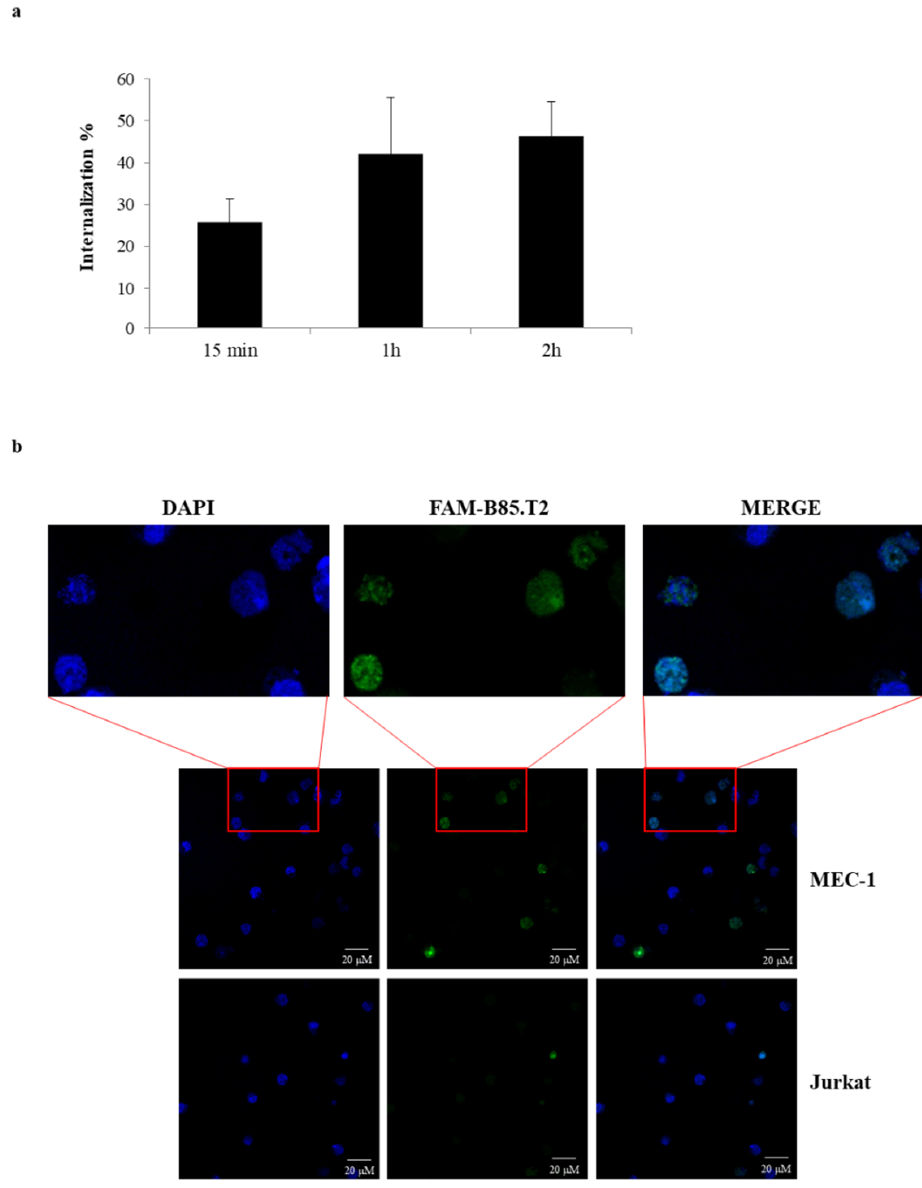
Figure 4. B85.T2 cell internalisation. ( a ) Internalisation of the B85.T2 aptamer on MEC-1 cells. FAM-labelled B85.T2 aptamer (250 nM) was incubated for the indicated times with cells, and then cells were recovered following three washings with PBS in order to recover total RNA, or one washing with trypsin-EDTA at 4 ◦ C followed by two washings with PBS in order to remove cell surface bound aptamers not internalised. The quantities of the total and internalised aptamer were measured at FACS by evaluating the mean fluorescence of each point. The mean fluorescence was measured at FACS, the cell auto-florescence from untreated cells was subtracted, and the aptamer internalisation rates were calculated and reported in the graph as percentage (%) of aptamer internalisation. Error bars show the mean of experimental duplicates ± SD values. ( b ) Indicated cells were incubated at 37 ◦ C for 2 h with 5 µ M FAM-labelled B85.T2. After treatment, cells were fixed with 4% PFA, mounted with SlowFade Diamond Antifade Mountant with DAPI to mark nuclei, and then the images were taken with Zeiss LMS700 confocal microscopy (oil objective 63 × , zoom 0.6). For MEC-1 cells, a higher magnification of each slice is also shown above. Images were processed equally to reduce the unspecific background. Scale bars depict 20 µ m length. Aptamer binding and internalisation into human CD19 + B cells were further confirmed by immunofluorescence using confocal microscopy. As shown in Figure 4b, upon 2 h of incubation, the FAM-labelled B85.T2 aptamer was found into MEC-1 CD19 + cells